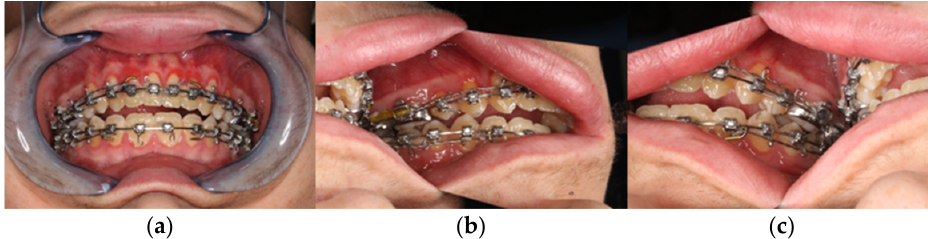
Figure 2. Clinical view from intraoral. ( a ) Frontal view in final bite position. ( b ) Posterior region left in occlusion. ( c ) Posterior region right in occlusion with presentation of the skeletal class III anomaly with circular crossbite and nonocclusion in the anterior region.